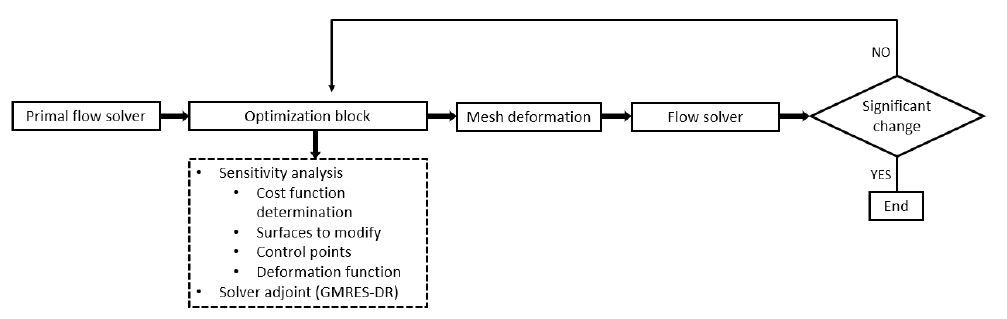
Figure 9. Flowchart of the implemented adjoint